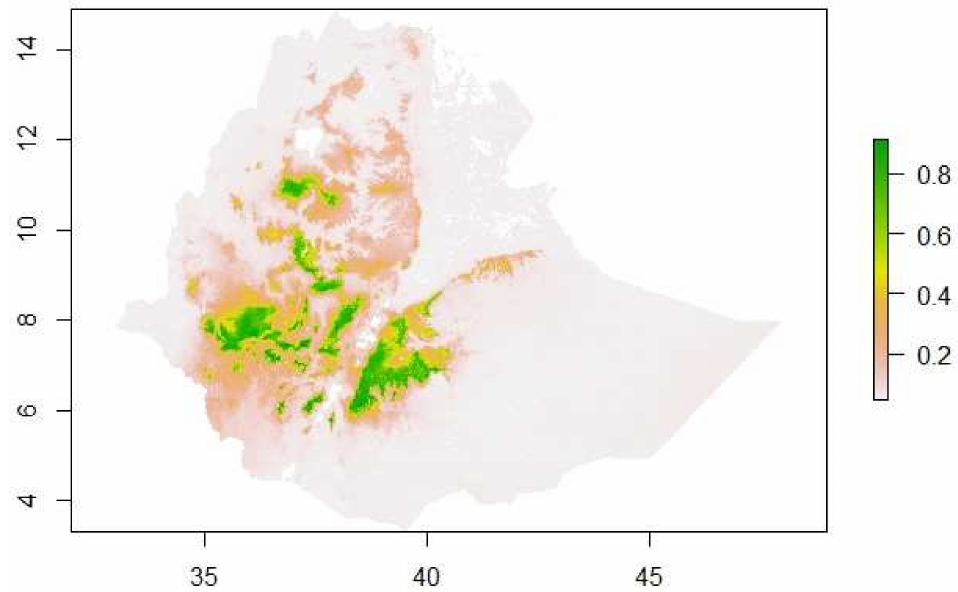
Figure 5. Predicted habitat suitability of highland bamboo in Ethiopia under future condition, SSP5-85 scenario, from the mean of the three